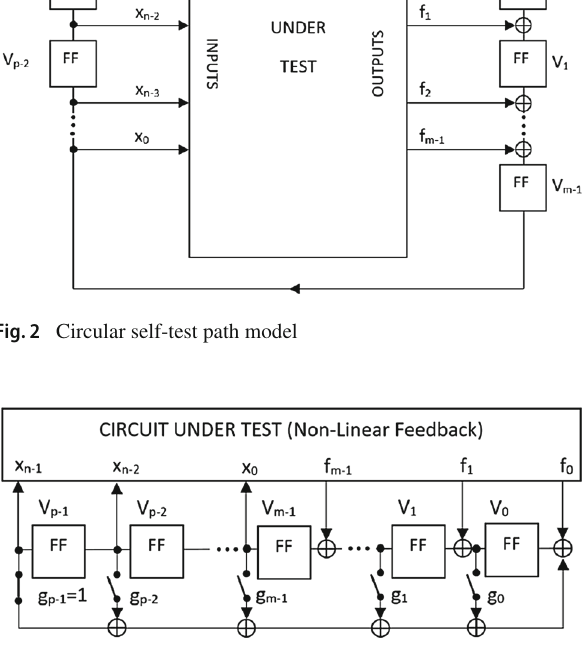
Fig. 3 External, top-feedback ExOR register